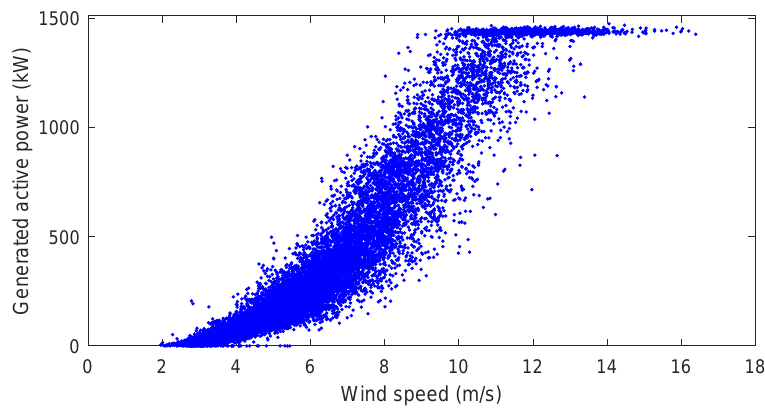
Figure 8. Power curve of the training